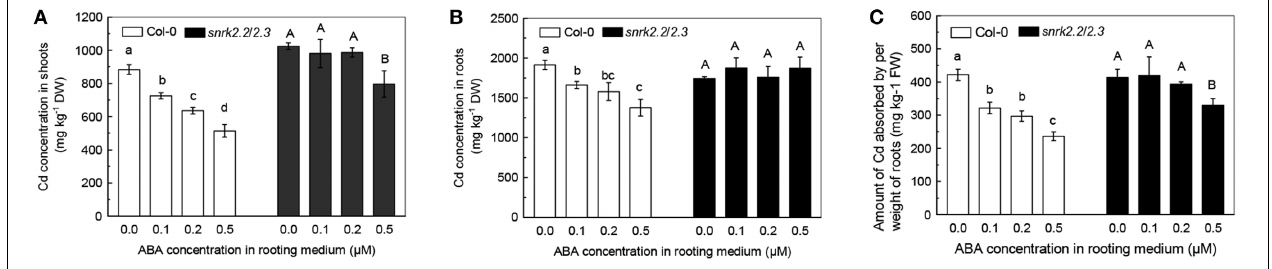
FIGURE 2 | Effects of varying doses of ABA on Cd levels and Cd uptake in Col-0 and snrk2.2/2.3 plants. Plants were grown in a nutrient solution with 10 µ M Cd and varying concentrations of ABA added for 7 days. The Fe level in the nutrient solution was 25 µ M. (A)